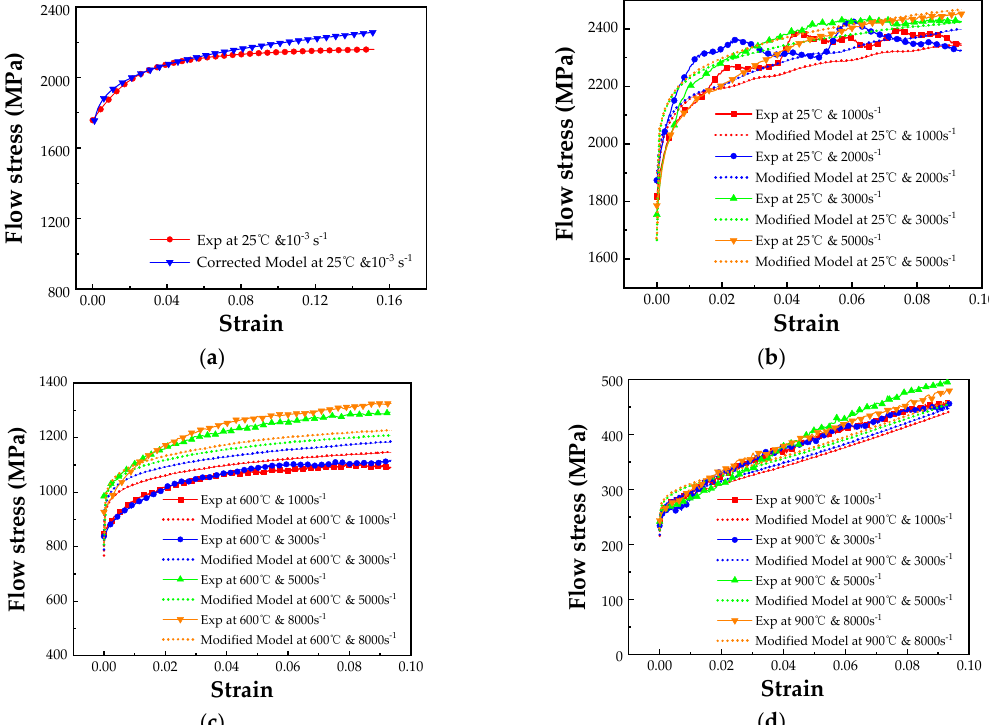
Figure 7. Comparison of experimental data and modified J-C model ( a ) quasi-static at 25 °C; ( b ) at different strain rate and 25 °C; ( c ) at different strain rate and 600 °C; ( d ) at different strain rate and 900 °C.